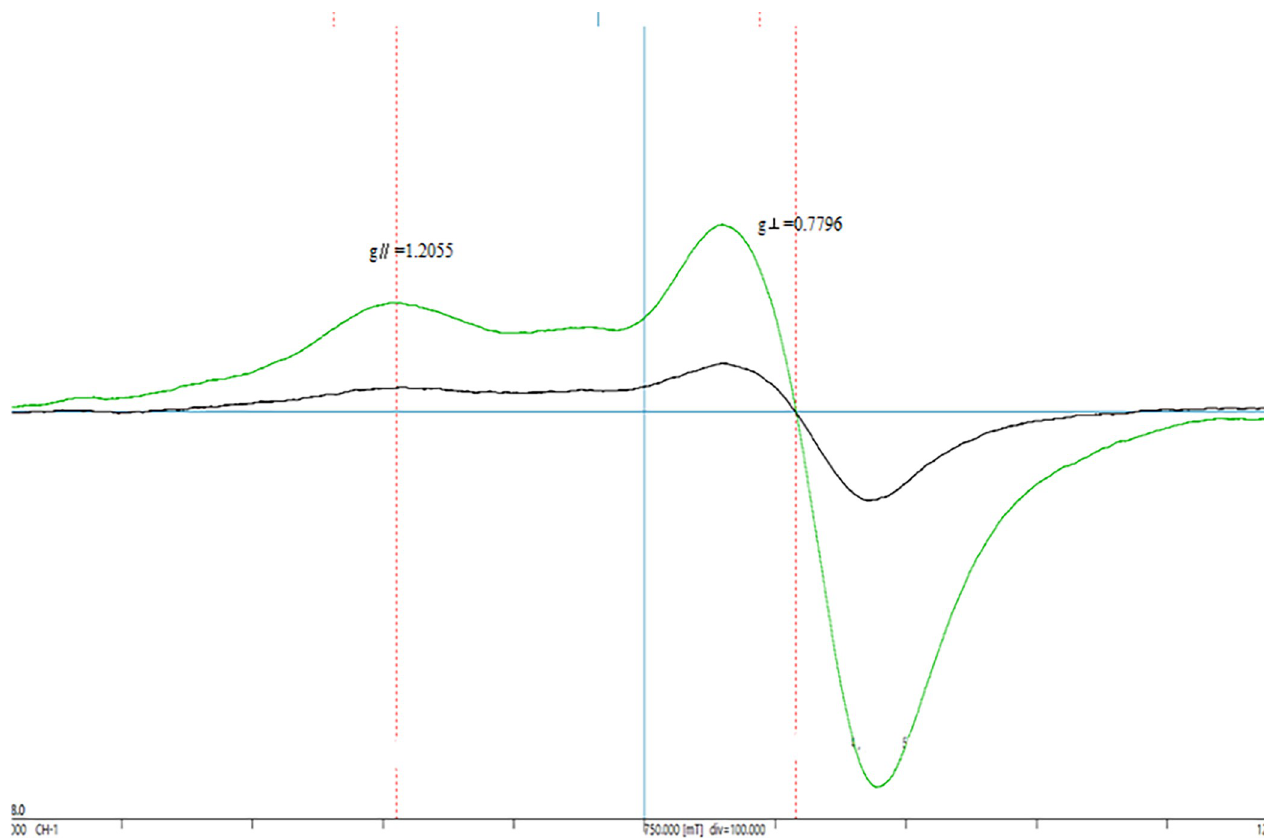
Fig 1. EPR spectra of pure gaseous oxygen and of air acquired under ambient conditions. The former and latter generated strong and weak peaks, respectively, for oxygen. EPR conditions: Resonance frequency 9.4566 GHz, resonance magnetic field 750 ± 500 mT, magnetic field modulation 100 kHz, modulation width 0.2 mT, amplification rate 100 × , time constant 0.3 s, observation time 4 min.